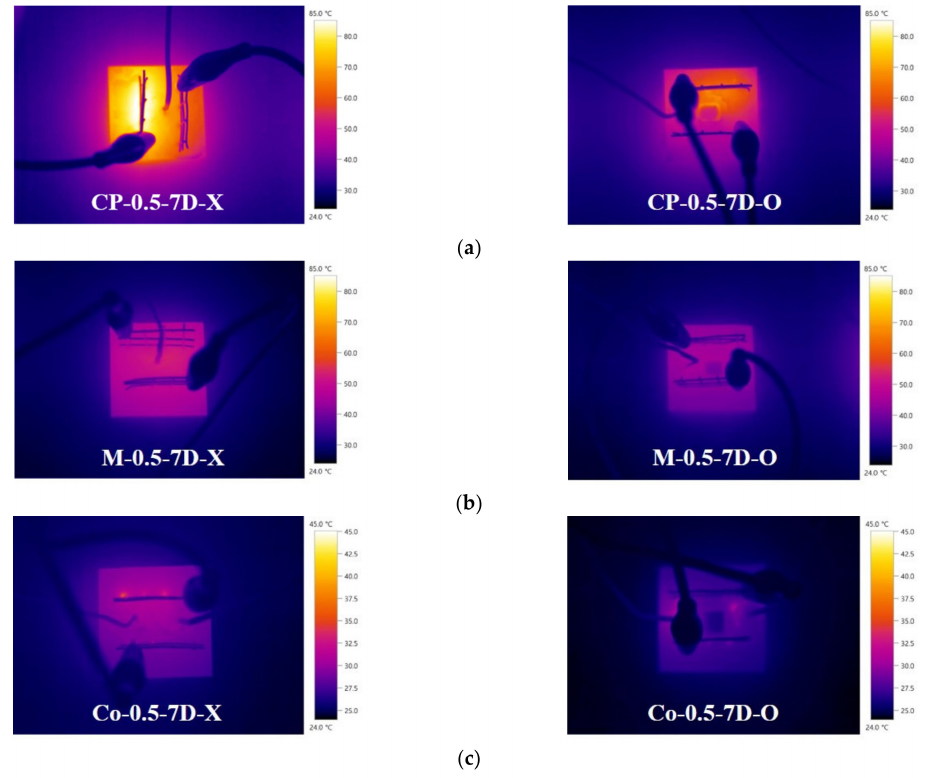
Figure 7. Thermal images at 7 curing days: ( a ) cement paste, ( b ) mortar, and ( c ) concrete (all at 60